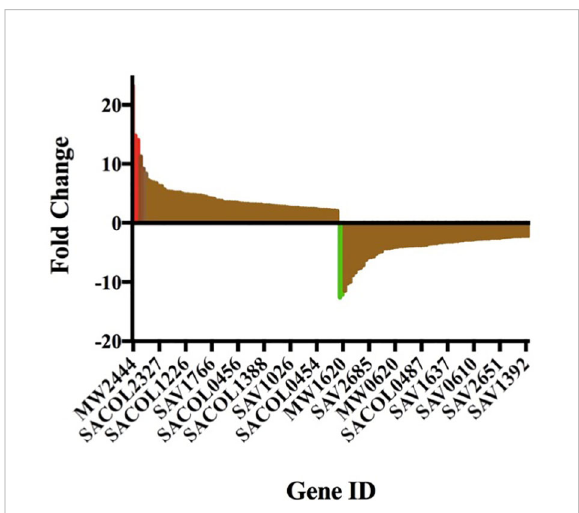
FIGURE 4 Gurmarin affects expression of Sa genes. Differentially expressed genes at 2-fold change is visualized in Prism 7 program. The upregulated and downregulated genes, including a few highly induced (red) and highly repressed genes (green), are shown. For gene details and fold changes, see Tables 1 and 2.